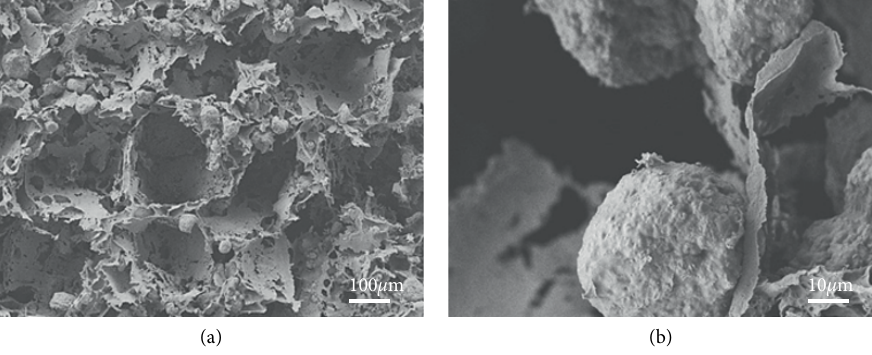
Figure 6: Morphologies of I-M/RP50 scaffolds.